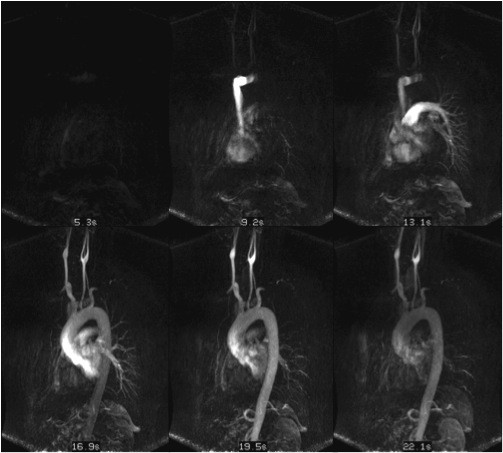
An example of MR-fluoroscopy is illustrated. MR-fluoroscopy can be used in place of test bolus techniques. In MR-fluoroscopy, continuous image acquisition with online image reconstruction is performed. Whenever the contrast bolus arrives in the area of interest, acquisition of the MRA-sequence can be either manually or automatically initiated. Even with the time-efficiency and ease-of-use of this technique, the abrupt switch from fluoroscopic measurements to the actual MRA-acquisition often minimizes the time for the patient to inspire for the breath hold, consequently increasing the risk of motion artifact.